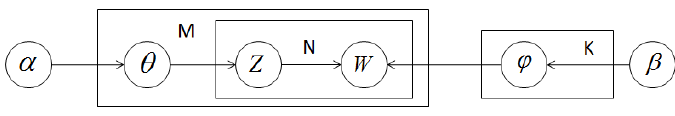
Figure 3. LDA topic